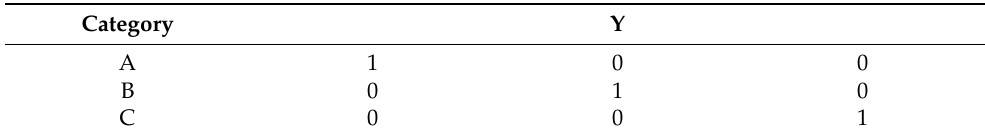
Table 1. The partial least squares-based discriminant analysis (PLS-DA) output matrix of a three- category